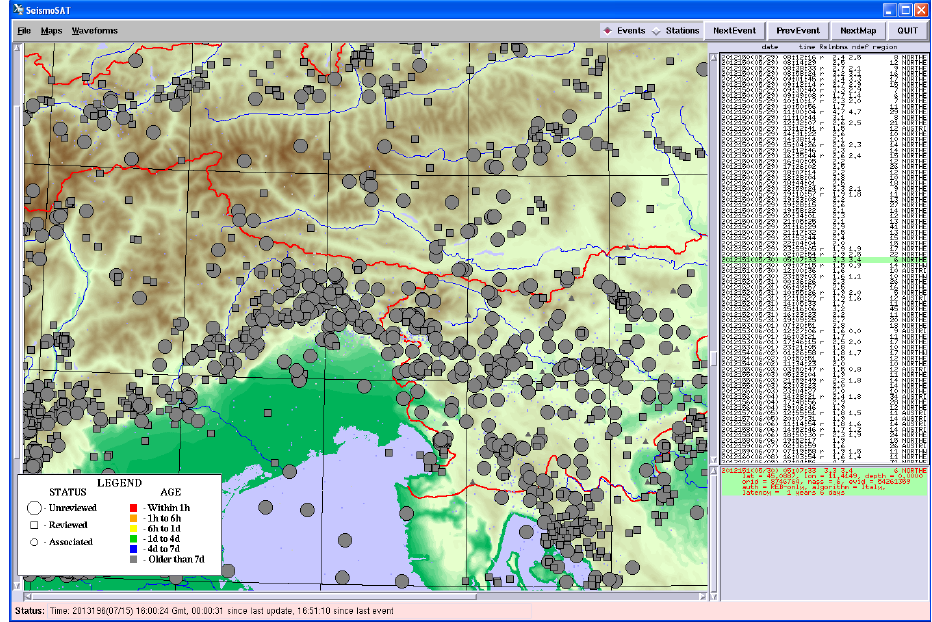
Figure 1. Seismicity map in the years 2011–2012 of the border region between Northeast Italy, Austria and Slovenia. In the map the events with magnitude M L >1.5 are shown. The plot is produced with the Antelope